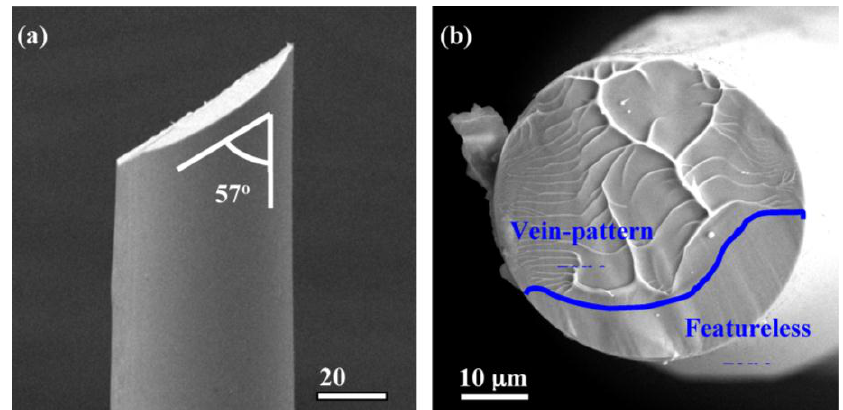
Figure 7. Fracture morphology of Cu 48 Zr 48 Al 4 amorphous microwires. ( a ) Fracture angle. ( b ) Fracture feature of the wires.